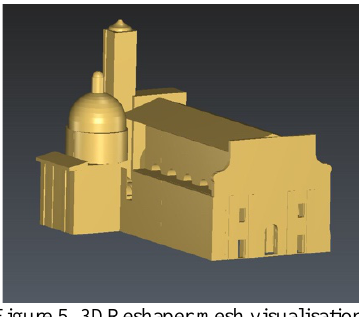
Figure 5. 3DReshaper mesh visualisation.